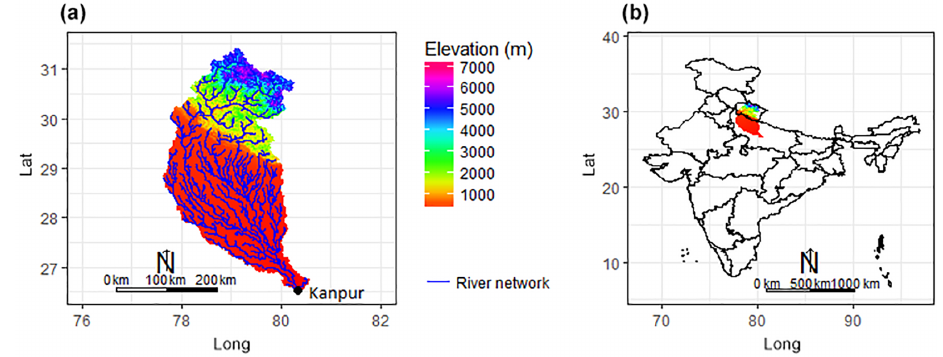
Figure 1. Location map of the study area in north India and a digital elevation model (DEM) of the Upper Ganges basin showing the ranges of the elevations (m altitude). Kanpur barrage was used as the outlet point.